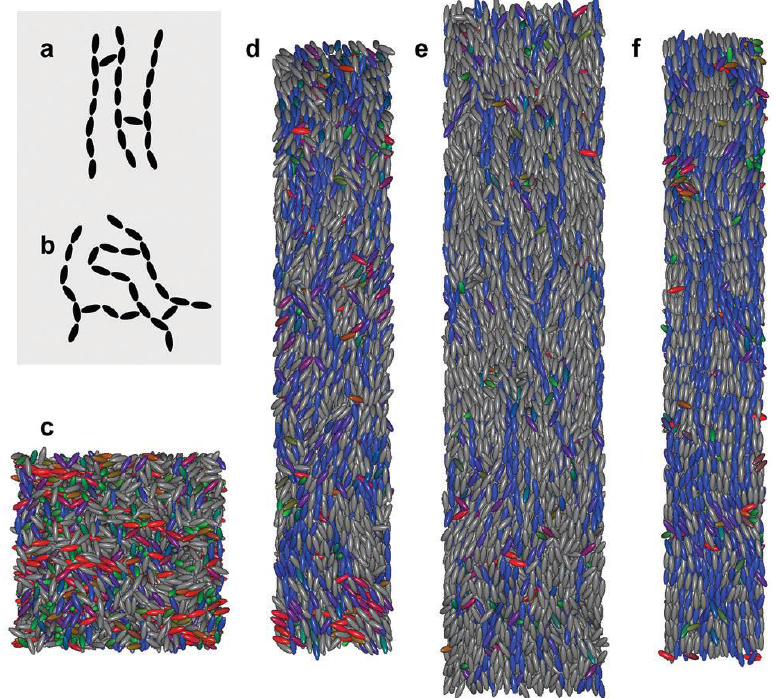
Figure 9. ( a , b ) illustrate the regular and irregular samples considered by [88]. ( c – f ) show the isotropic, nematic (less swelling), nematic (more swelling) and smectic phases, respectively (Reprinted with permission from [88]).